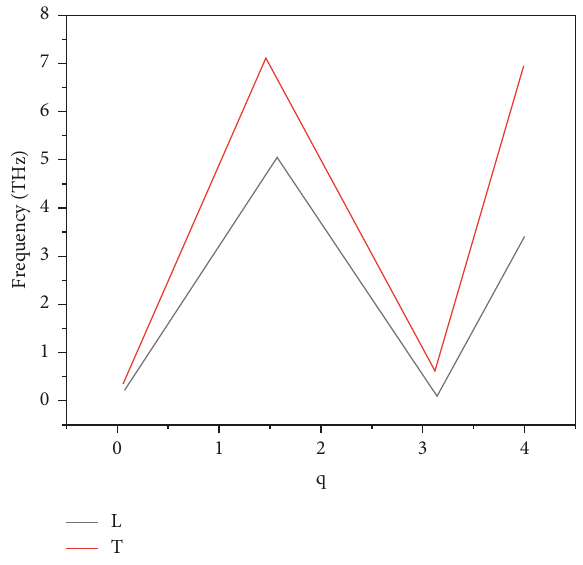
Figure 5: Phonon dispersion curve q of Cu crystal.